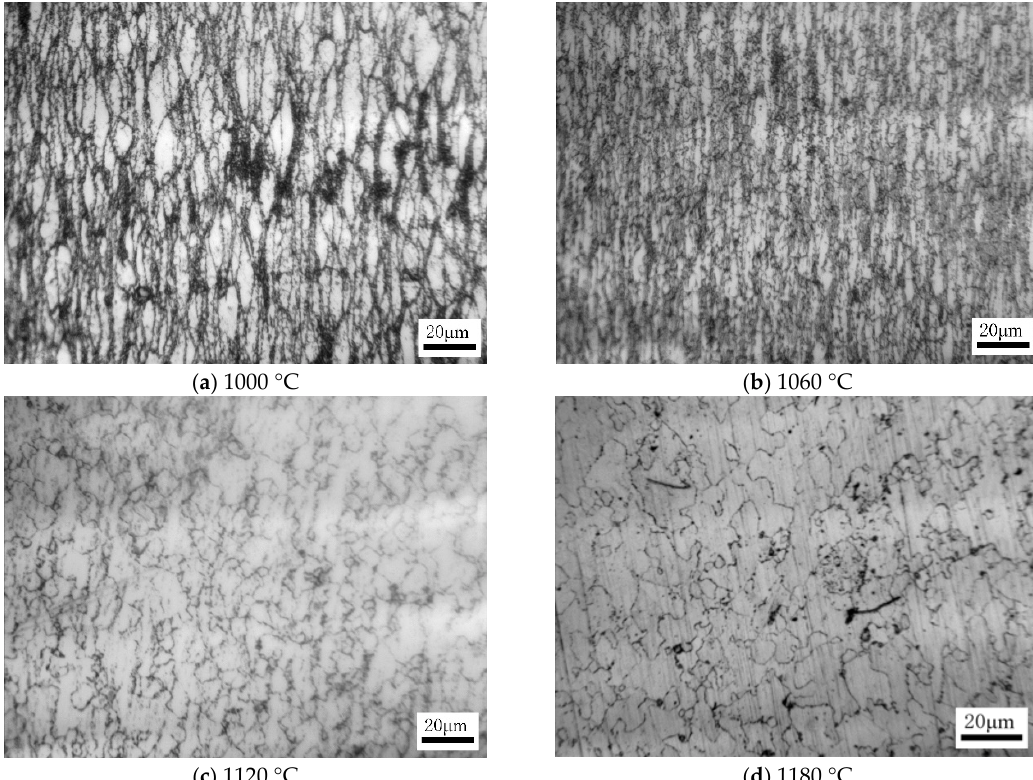
. ε = 0.1 s − 1 ; ( b ) 1060 ◦ C, . . ε = 0.1 s − 1 ; ( d ) 1180 ◦ C, ε = 0.6, ε = 0.1 s − 1